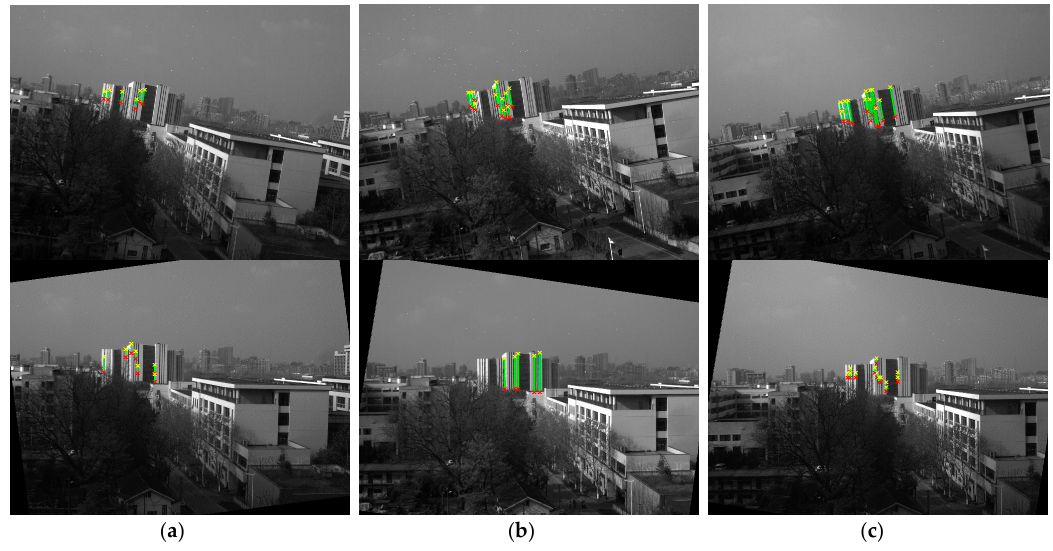
Figure 12. Images with lines detected before (first row) and after (second row) horizontal correction. Table 6. Coordinates and angles of each detected plumb line before and after horizontal correction. Line No. Line